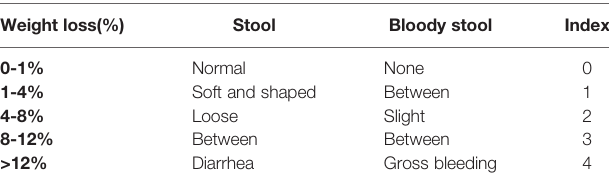
TABLE 2 | Disease activity index score parameters (DAI).